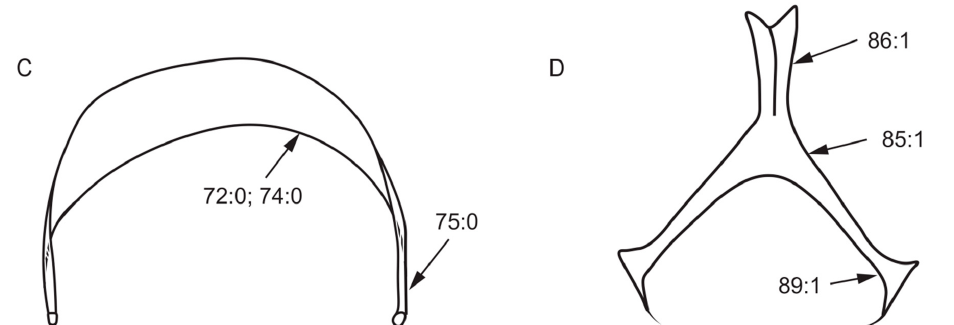
Figure 6. Syntergosternite and hypandrium characters. ( A ): Homoneura ( Homoneura ) dorsacerba ; ( B ): Homoneura ( Homoneura ) posterotricuspis ; ( C ): Homoneura ( Homoneura ) procerula ; ( D ): Cestrotus liui . 77. Surstylus: (0) separated from epandrium (Figure 7D); (1) not separated from epandrium (Figure 7B). 78. Number of surstylus processes: (0) one (Figure 7D); (1) two or more (Figure 7C). 79. Length of the longest surstylus/height of epandrium: (0) ≥ 1/2 (Figure 7A); (1) < 1/2 (Figure 7B). 80. Shape of the apex of surstylus: (0) sharp (Figure 7A); (1) blunt (Figure 7C). 81. Shape of surstylus: (0) bent (Figure 7A); (1) straight (Figure 7B).